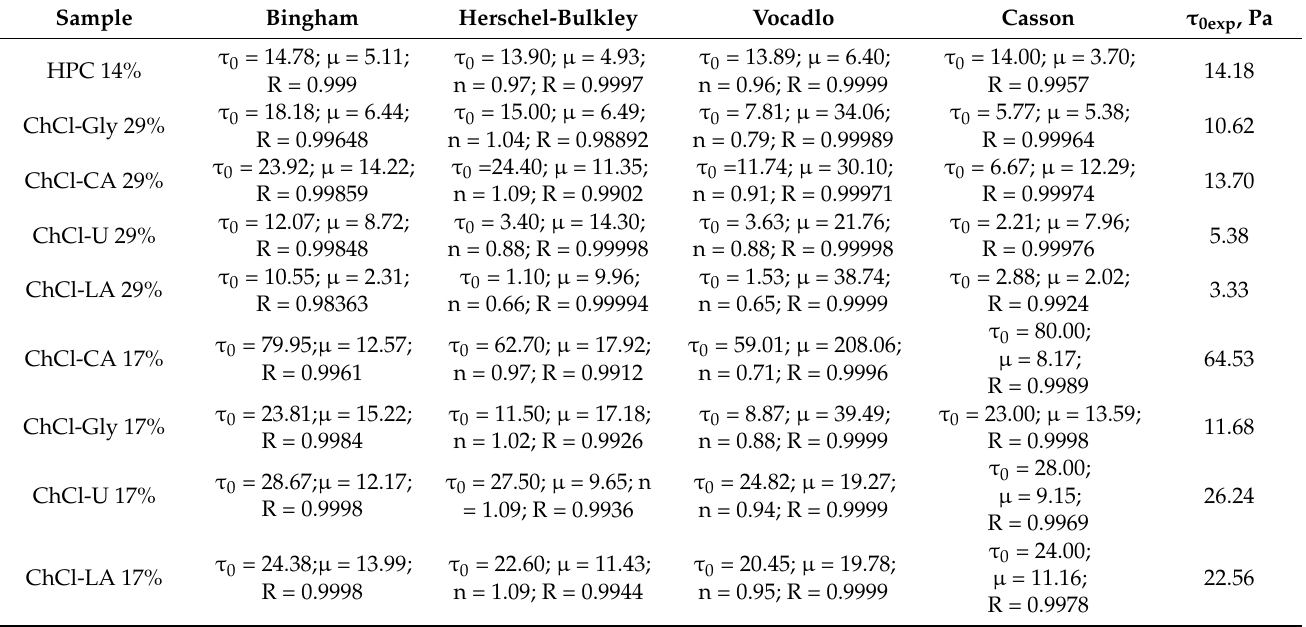
Table 5. The shear stress-shear rate curves coefficients of HPC (solution 14%) and HPC-NADES 17% and 29%.